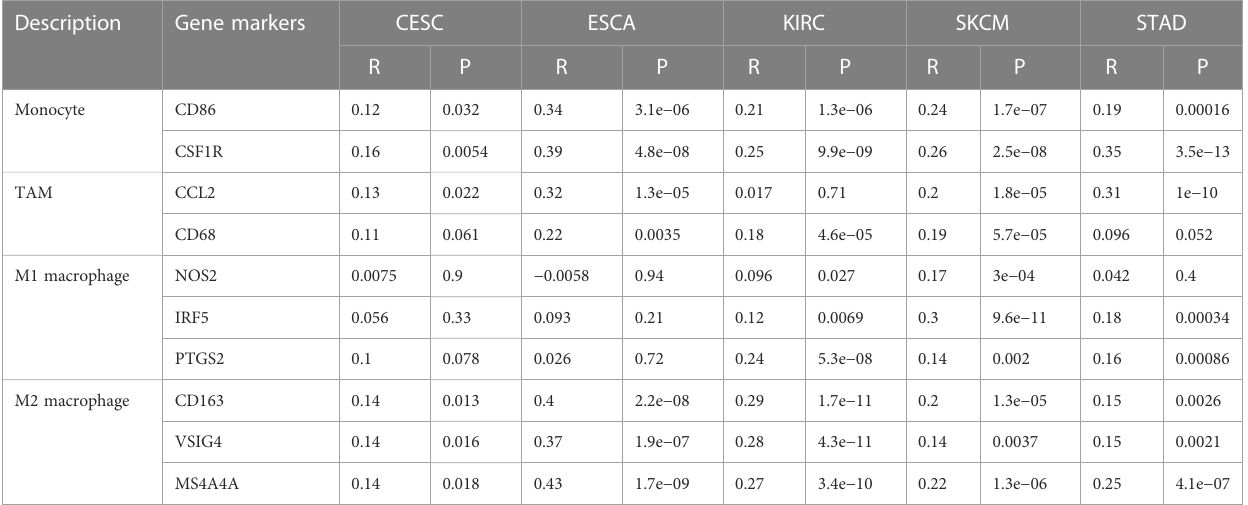
TABLE 3 Correlation analysis between scavenger receptor class A member 5 ( SCARA5 ) and immune cell-related genes and markers in Gene Expression Pro fi ling Interactive Analysis (GEPIA).